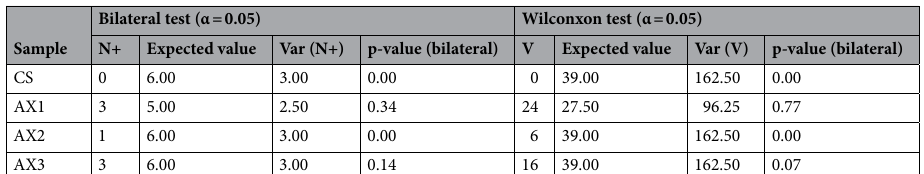
Bilateral test (α = Sample